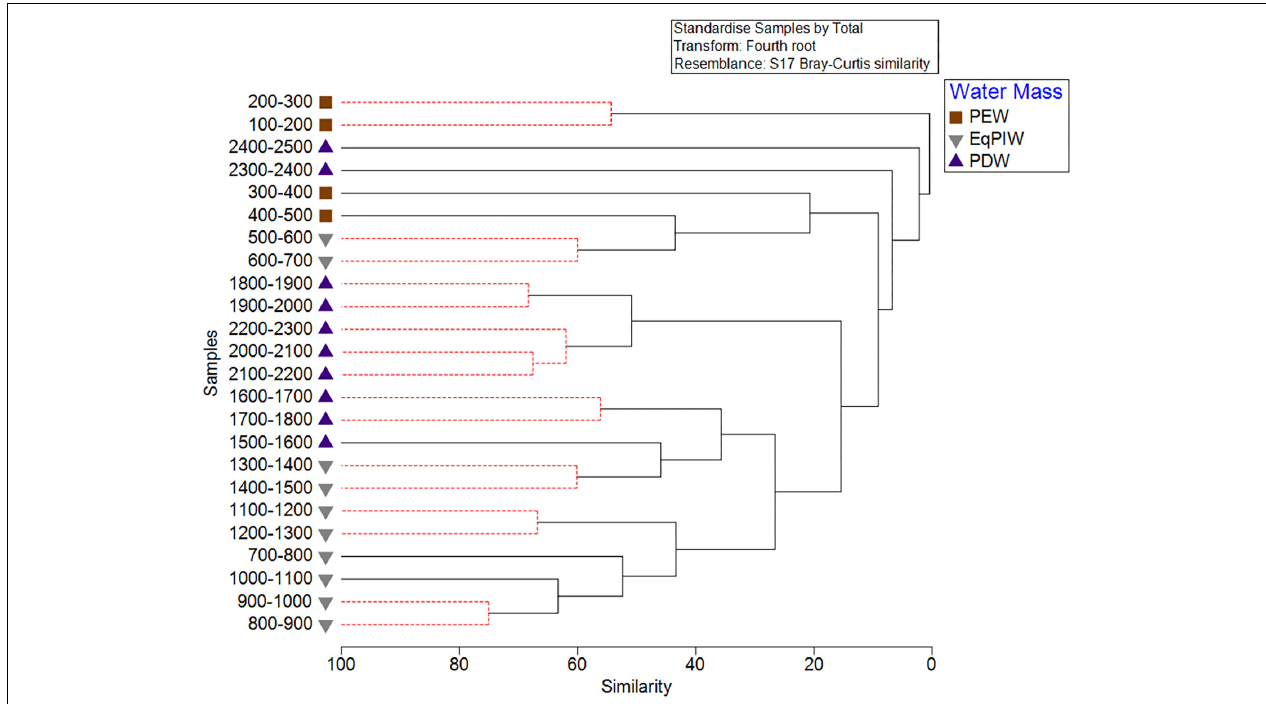
FIGURE 6 | Cluster analysis of 100 m depth-averaged samples. Significant clusters are identified using SIMPROF analysis and are indicated by solid black lines. Symbols indicate the water masses in which those samples occurred.